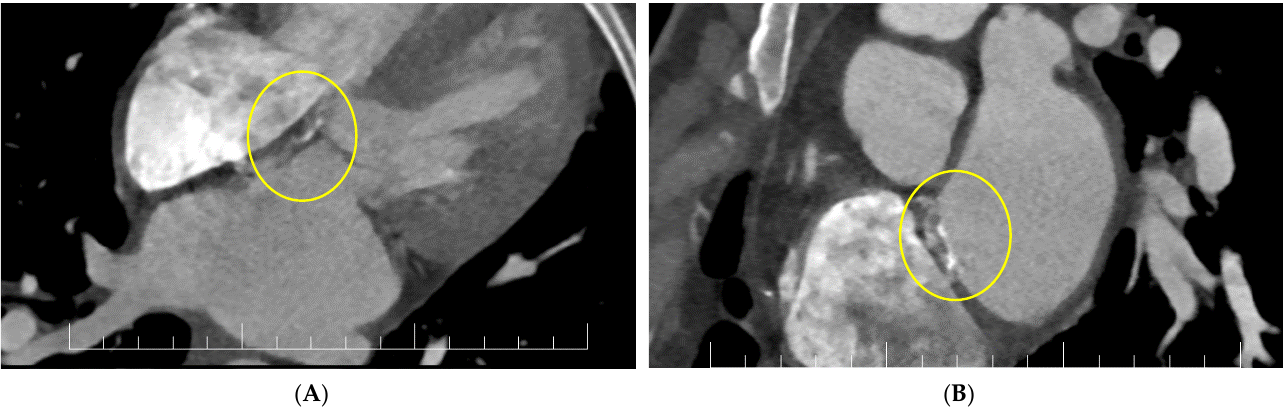
Figure 5. ( A , B ) Cardiac CT: interatrial septal patch abscess with a fistulous path (inside circles).